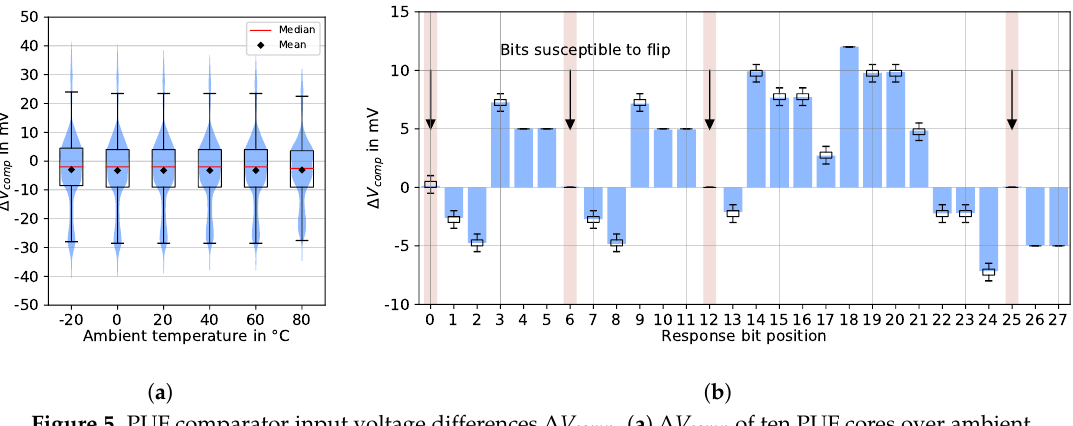
Figure 5. PUF comparator input voltage differences ∆ V comp . ( a ) ∆ V comp of ten PUF cores over ambient temperature range, ( b ) ∆ V comp per response bit of one selected PUF core (no.